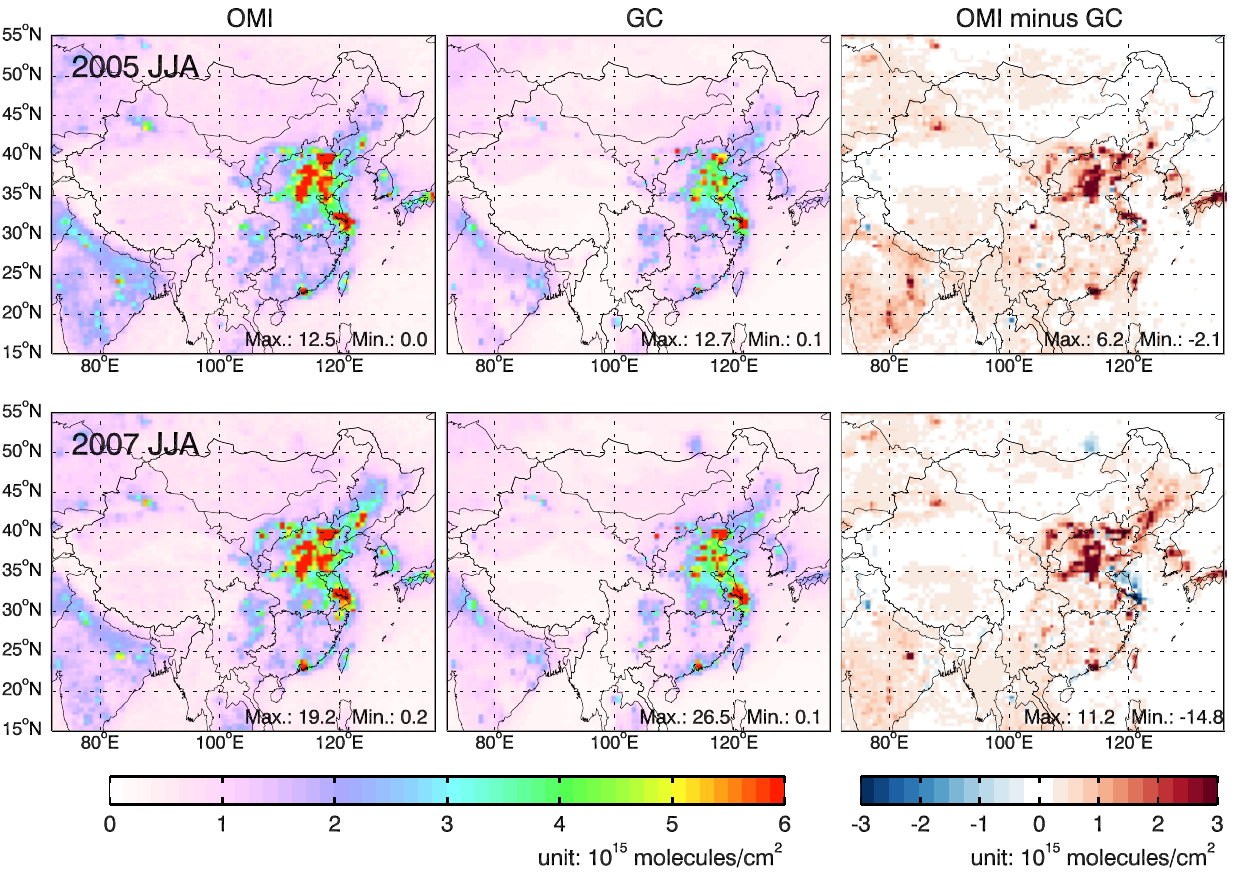
Fig. 6. OMI and GEOS-Chem tropospheric NO 2 columns for summers (JJA) of 2005 (top) and 2007 (bottom) and their